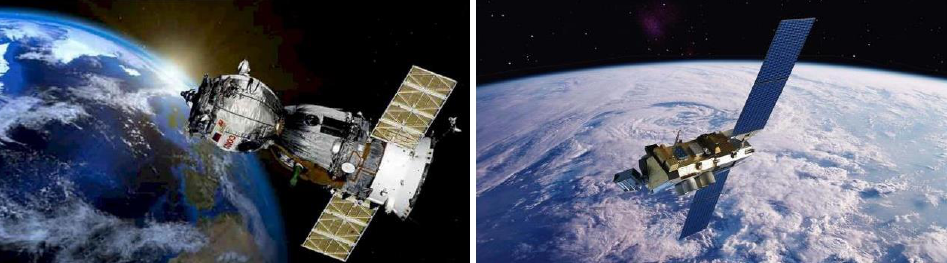
Figure 6. The selected clear images.